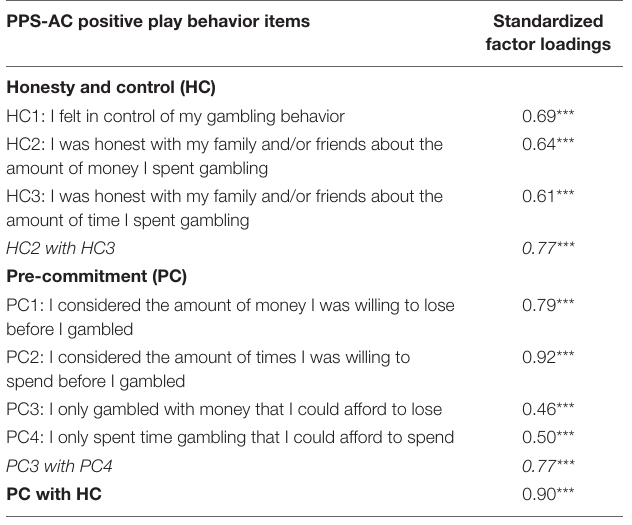
TABLE 1 | Confirmatory factor analysis results of positive play behavior items among past-year gamblers ( N = 236). PPS-AC positive play behavior items Standardized